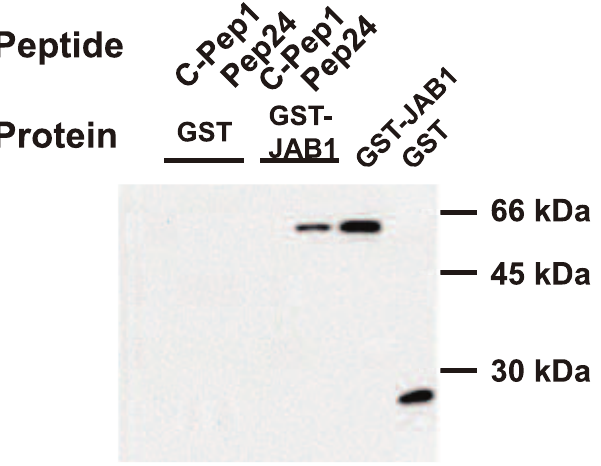
Figure 4. Pep24 specifically binds to JAB1. The indicated biotin- conjugated peptides were incubated with GST or with the GST-fused JAB1. The complex of peptide-GST fusion protein immobilized on streptavidin-agarose was detected by western blotting with anti-GST antibody.